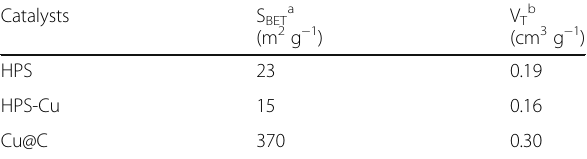
Table 1 Textural parameters of the products obtained after each step: HPS, HPS-Cu, and Cu@C